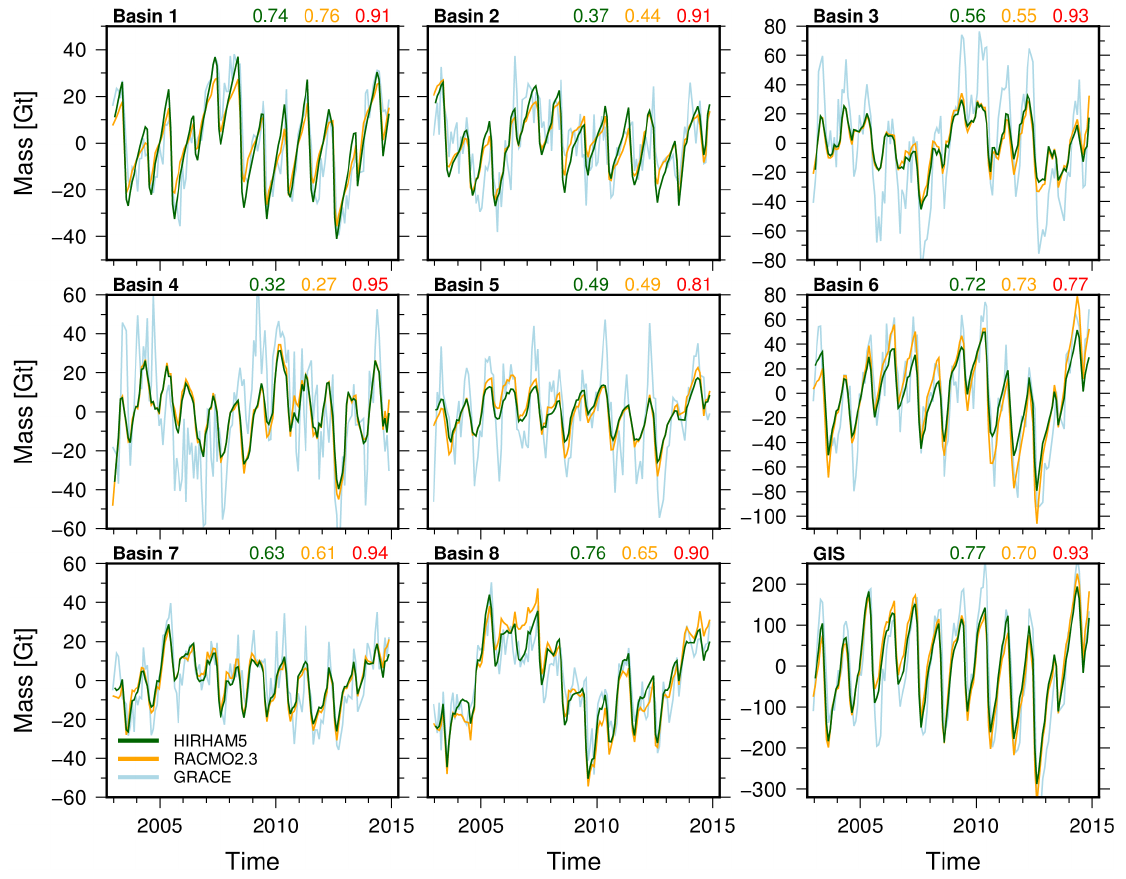
Figure 7. Intercomparison of mass changes from GRACE (Greenland ice sheet CCI GMB product) and two regional climate models (HIRHAM5 and RACMO2.3) for different drainage basins (cf. inset in Figure 4) and the entire Greenland ice sheet. Mass changes are given w.r.t. a linear and quadratic model and exclude the long-term signal. Numbers indicate the Nash-Sutcliffe model efficiency coefficients for: GRACE vs. HIRHAM5 (green), GRACE vs. RACMO2.3 (orange) and HIRHAM5 vs. RACMO2.3